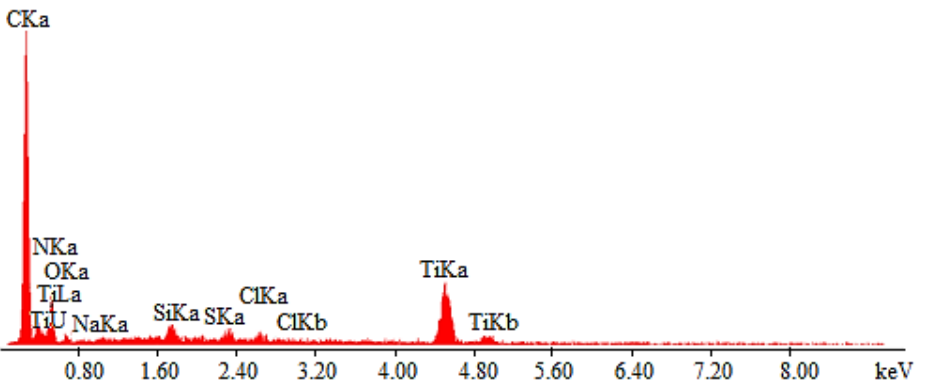
Figure 8. SEM image of Ti-Si coated NATAN fabric at magnification of ( a ) 350×; ( b ) 2000×; point “1” is marked for EDS analysis.